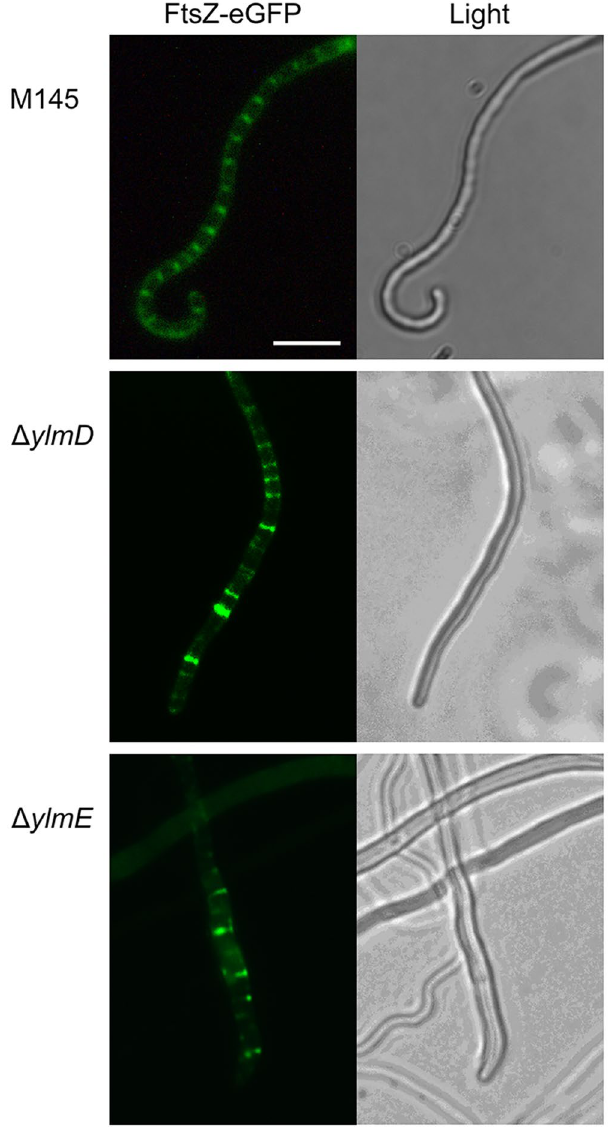
Figure 7. Localization of FtsZ-eGFP in S. coelicolor M145 and its ylmD and ylmE mutants. FtsZ-eGFP formed typical ladders in wild-type cells (M145). In contrast, YlmE is required for the formation of ladders of FtsZ, while the absence of YlmD caused irregular spacing between the septa. Cultures were grown on SFM agar plates for 5 days at 30 °C. Bar, 5 μ